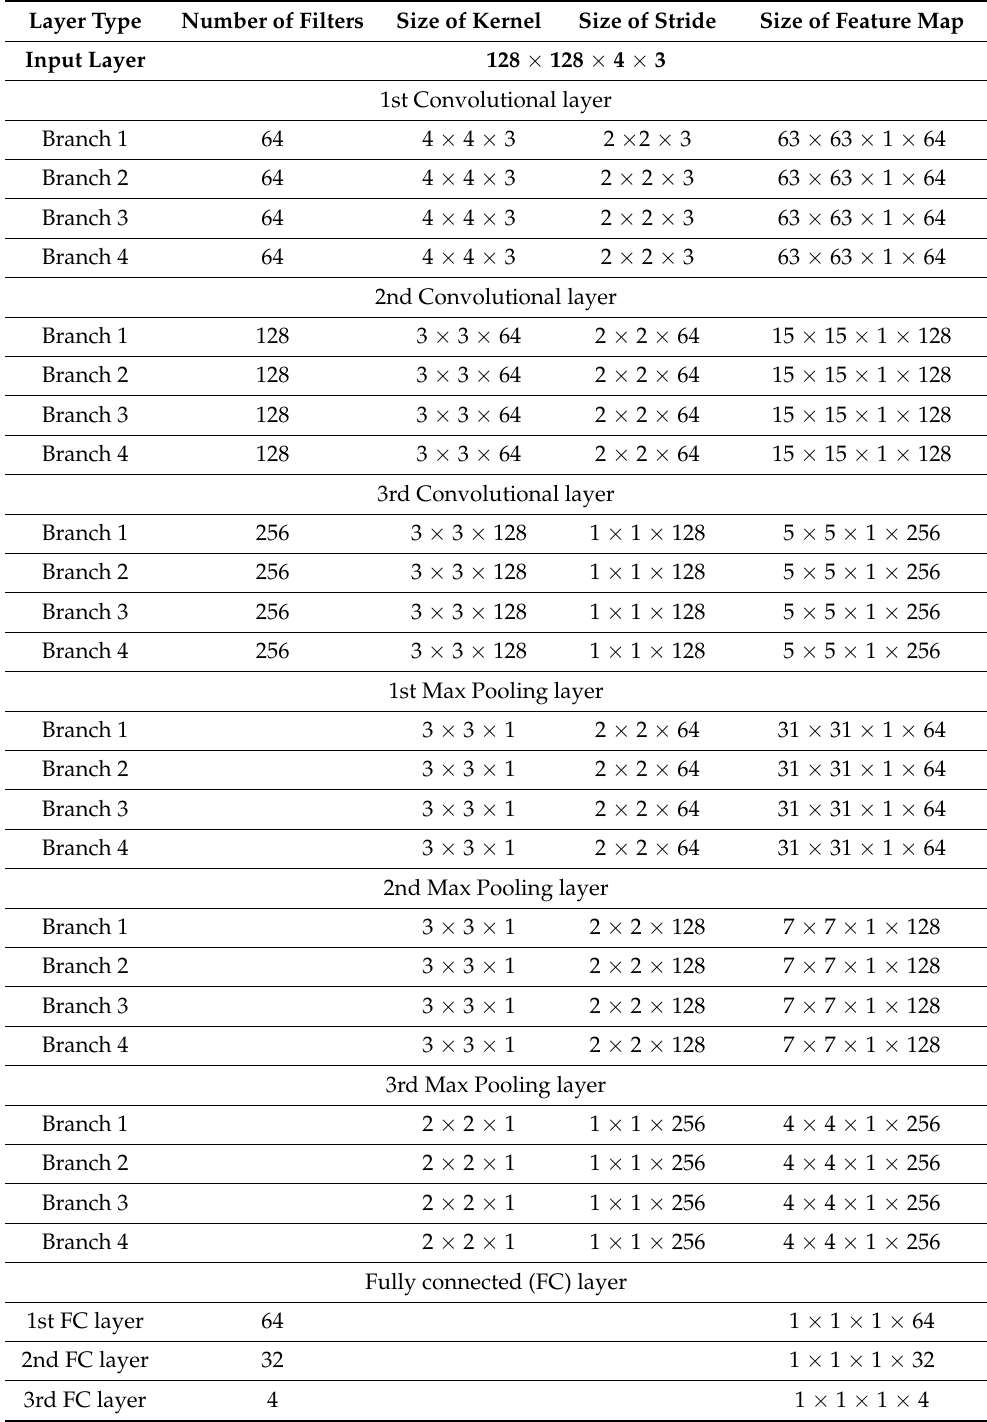
Table 1. The architecture of the proposed